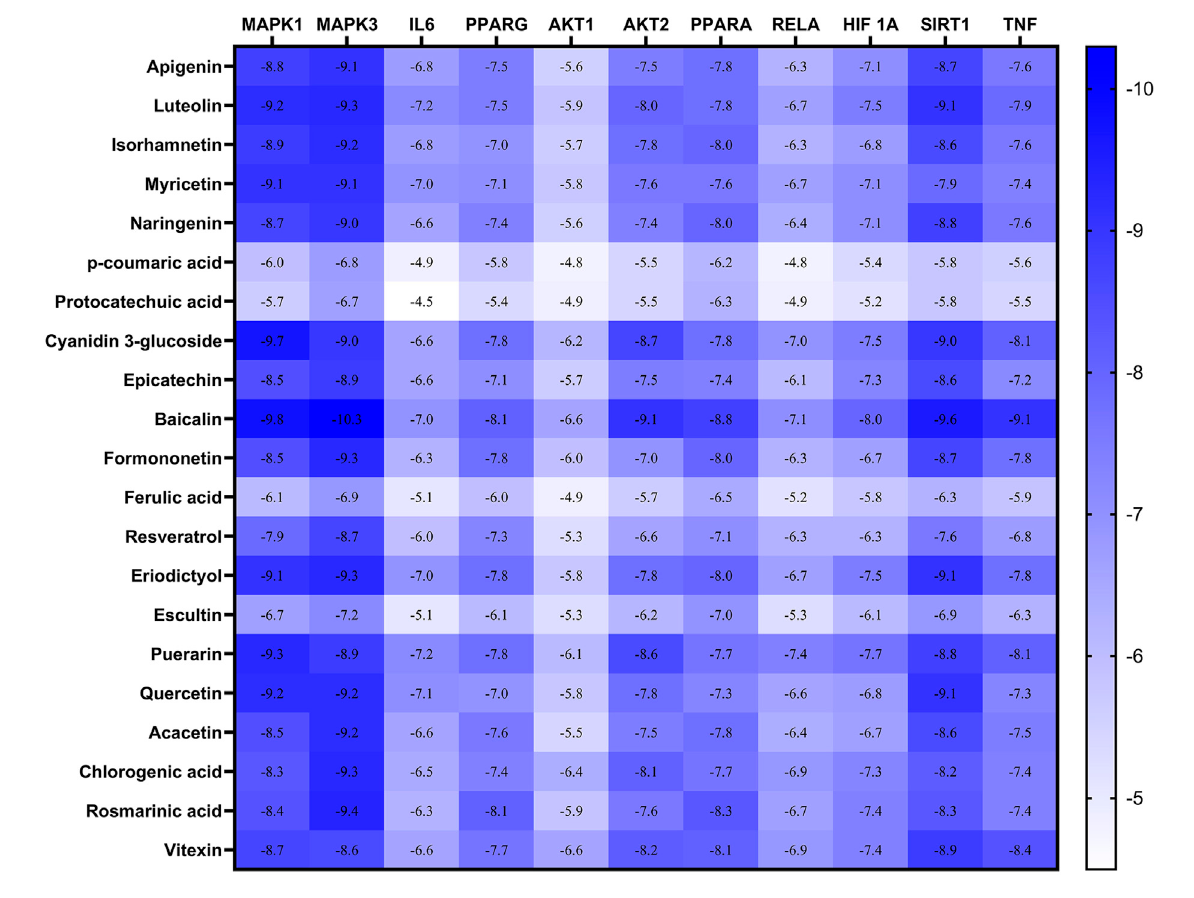
FIGURE 9 Heatmap represents the docking results and af fi nity of 21 compounds with 11 proteins from the core targets. The more bluish the rectangle is, the stronger the af fi nity. Adjusting the size of the images and resolution was carried out using